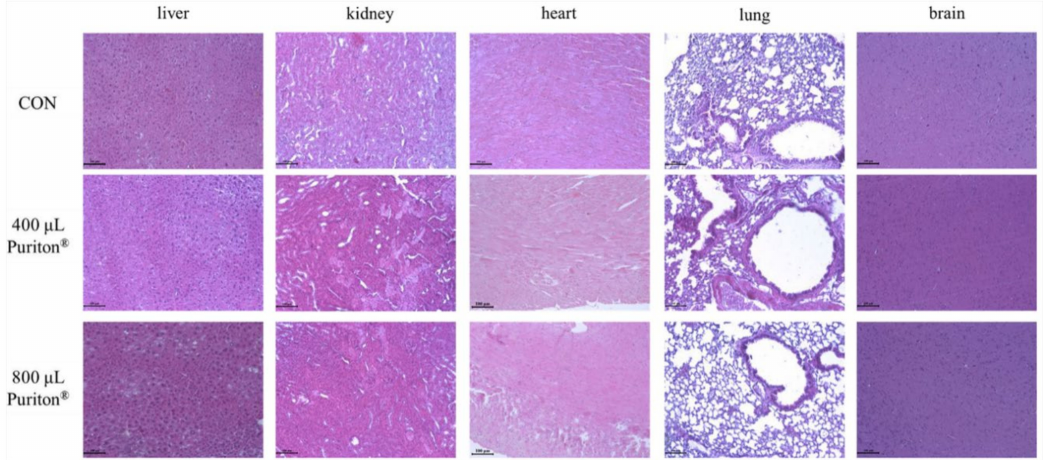
Figure 5. Results of histopathological analysis of Puriton ® in the brain, heart, kidney, liver, and lungs. Scale bar, 100 µ m; magnification, ×